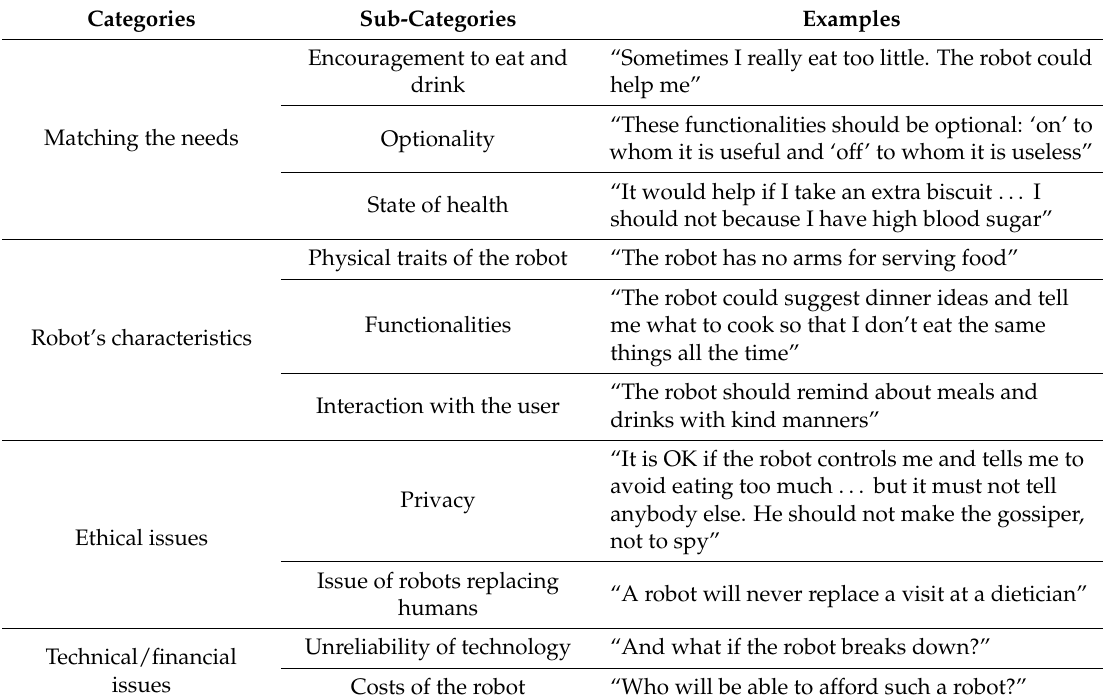
Table 2. Qualitative analysis of respondent statements.